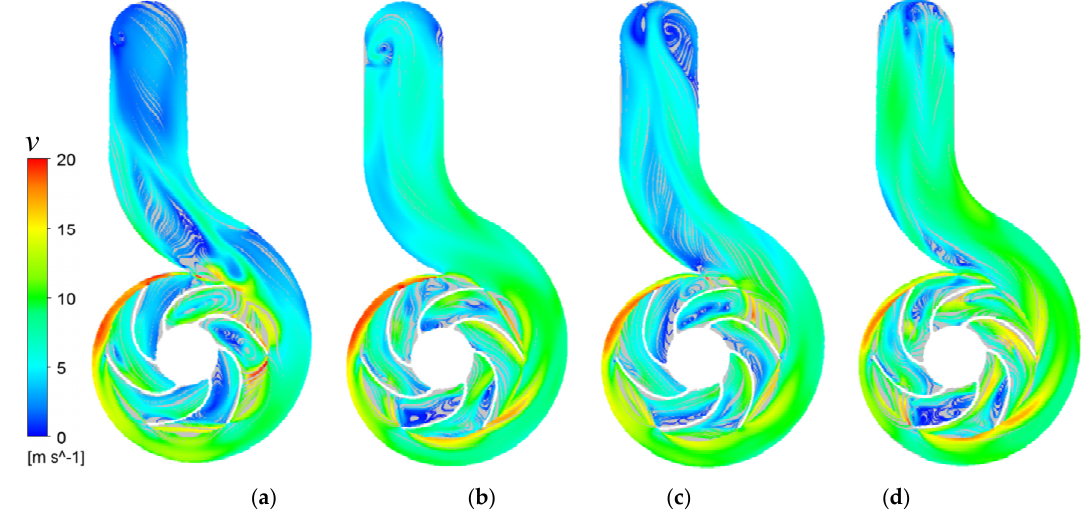
Figure 13. Velocity streamline line of model pump: ( a ) 0.5 Q r , ( b ) 0.7 Q r , ( c ) 1.0 Q r , ( d ) 1.2 Q r .